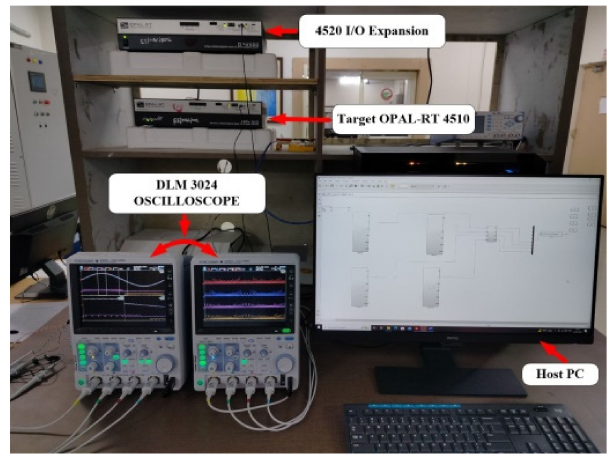
Figure 11. Experimental set-up using OPAL-RT